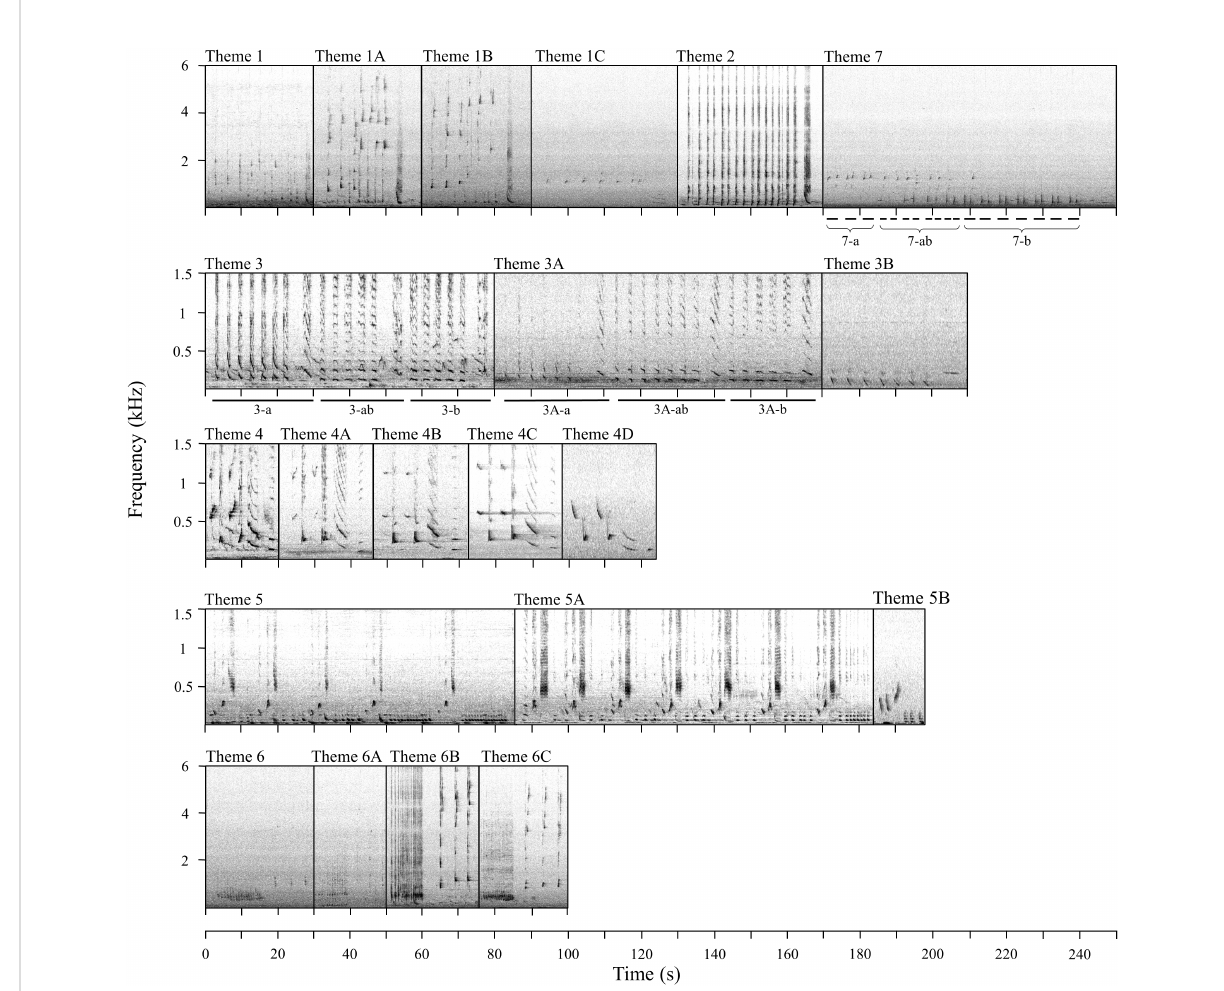
FIGURE 3 Spectrographic representation of all observed themes and phrase types from the recording period January 2018 - January 2019. The spectrograms were produced using fast Fourier transform (FFT) size 8092 Hann-window with frequency resolutions of 5.69 Hz (for 2018 fi les) and 11.4 Hz (for 2019 fi les), and a 70% overlap. Corresponding audio fi les are provided in Supplementary Audios 1-11. Note that themes are not ordered according to how they occurred in songs but rather follow the evolutionary